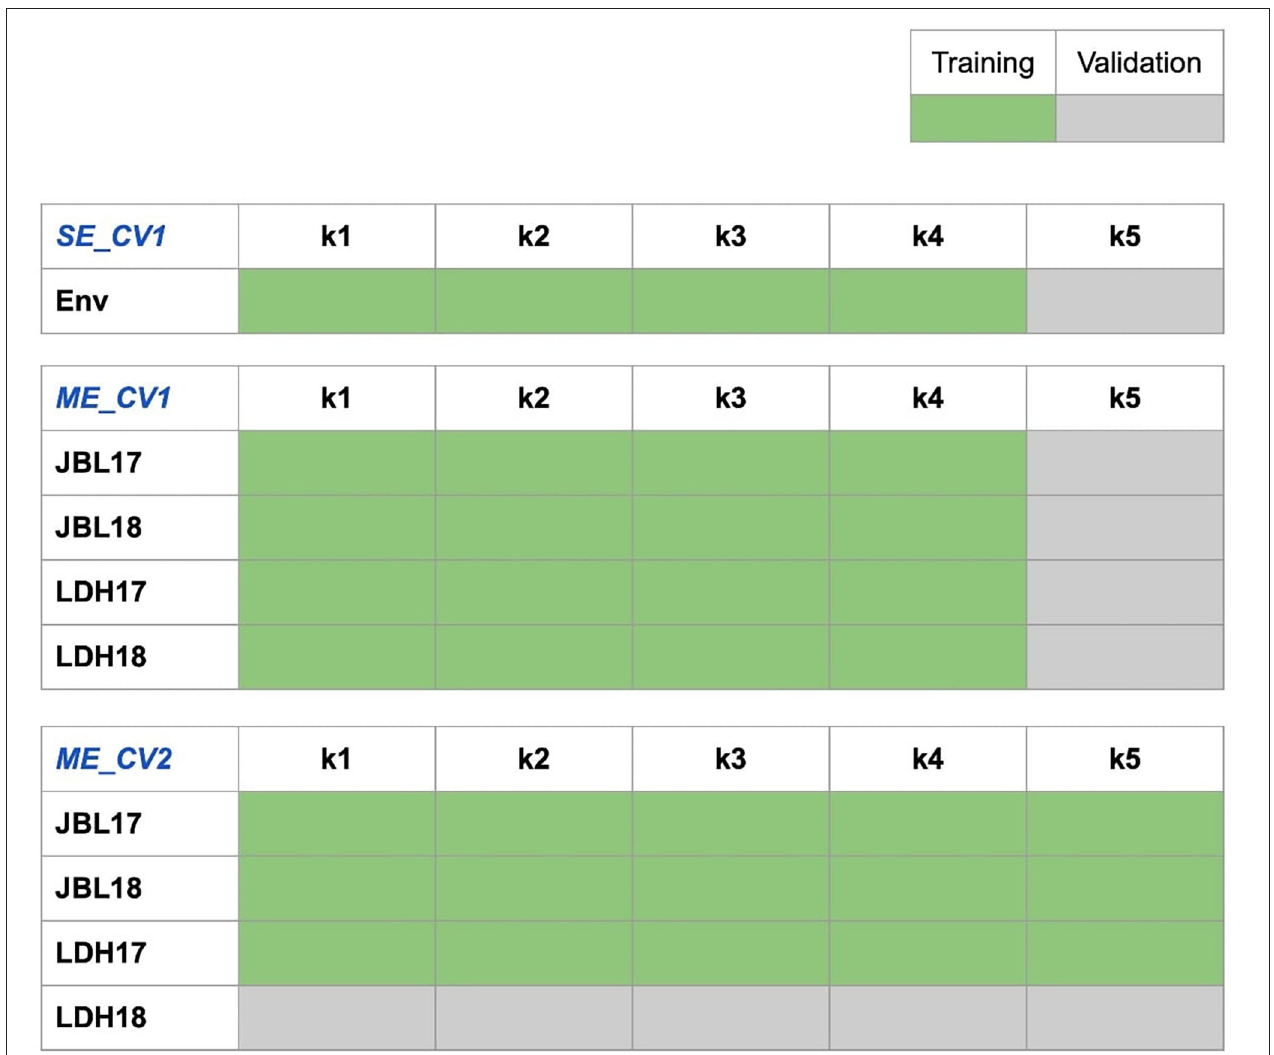
FIGURE 1 | Prediction scheme for the single-environment (SE) and multi-environment (ME) genomic prediction models with two cross-validation schemes (CV1 and CV2) used in this study. SE_CV1 model: the SE prediction model with CV scheme 1 where a trait [e.g., grain yield (GRYLD)] is predicted at a time; we used 80% of individuals as the training set (phenotyped and genotyped, light green) and 20% of the individuals as the testing set (genotyped only, light gray with validation code for the trait to be predicted, yield as an example here). ME_CV1 model: the ME prediction model with CV scheme 1 for new un-phenotyped individuals; we used 80% of individuals as the training set (phenotyped for all traits and genotyped; light green) and 20% of the individuals as the validation set (genotyped but not phenotyped for any trait; light gray with validation code for the trait to be predicted, GRYLD as an example here). ME_CV2 model: the ME prediction model with CV scheme 2 where 100% of the information from other traits are available for the individuals to be predicted; we used 80% of individuals as the training set (phenotyped for all traits and genotyped; light green) and 20% of individuals as the validation set (phenotyped for associated traits but not for the targeted traits, and genotyped; light gray with predication code for the trait to be predicted, yield as an example here). Rectangles represent genotypes, and colors represent whether the phenotypic information was used (light green) or not (light gray with validation code for the trait to be predicted, GRYLD as an example) for the population. A similar scheme was applied for predicting days to heading (DTHD), days to maturity (DAYSMT), and thousand-grain weight